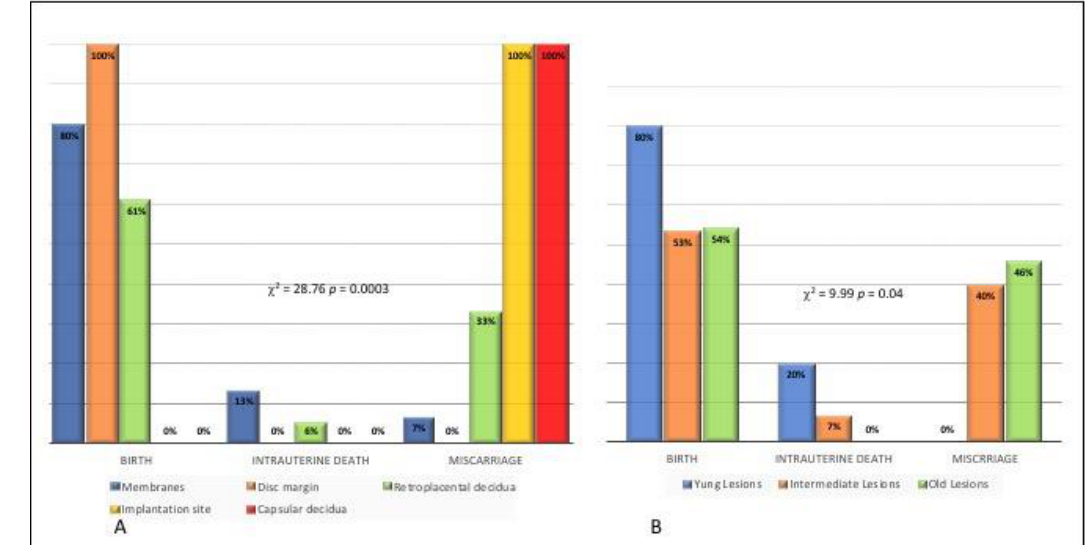
Figure 4. Pregnancy outcome in relation to site of laminar necrosis ( A ) and time of onset of laminar necrosis ( B